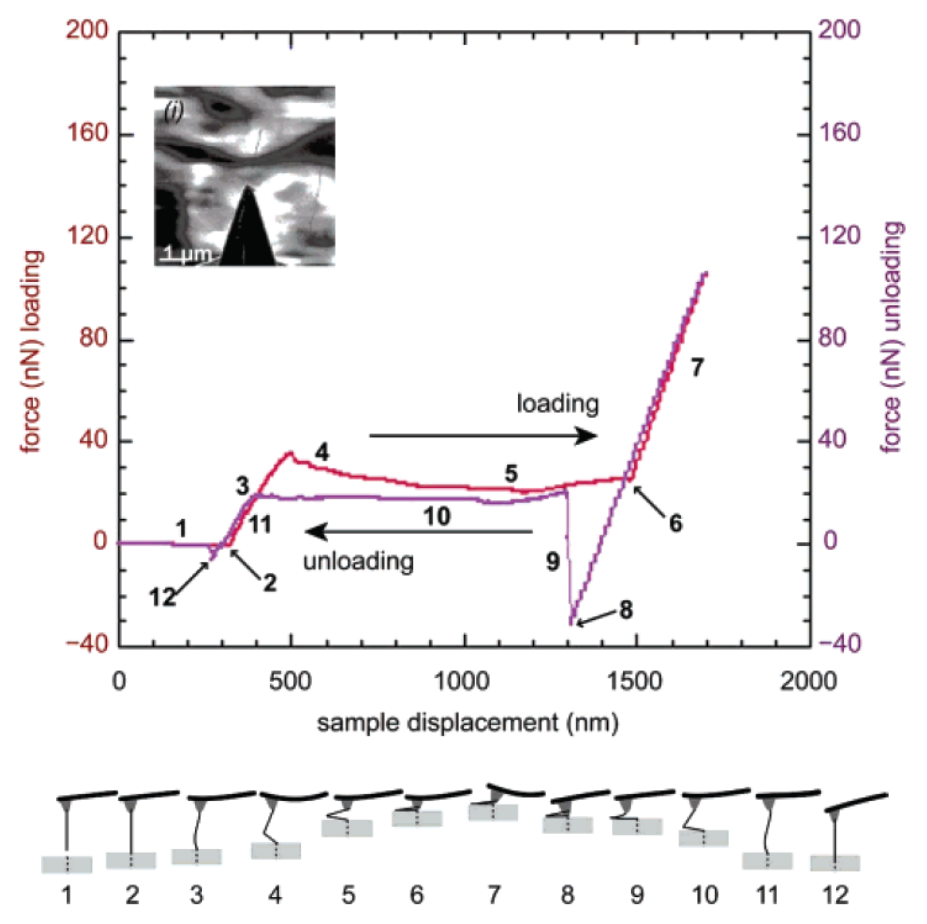
Figure 4. [Top] Force-displacement curve of an MWNT with an aspect ratio of ∼ 80 under cyclic axial loading. This inset shows a microscopy image; [Bottom] Schematic of the change in the MWNT configuration during the buckling process. The labels correspond to those indicated in the force-displacement curve. Reprinted from Reference